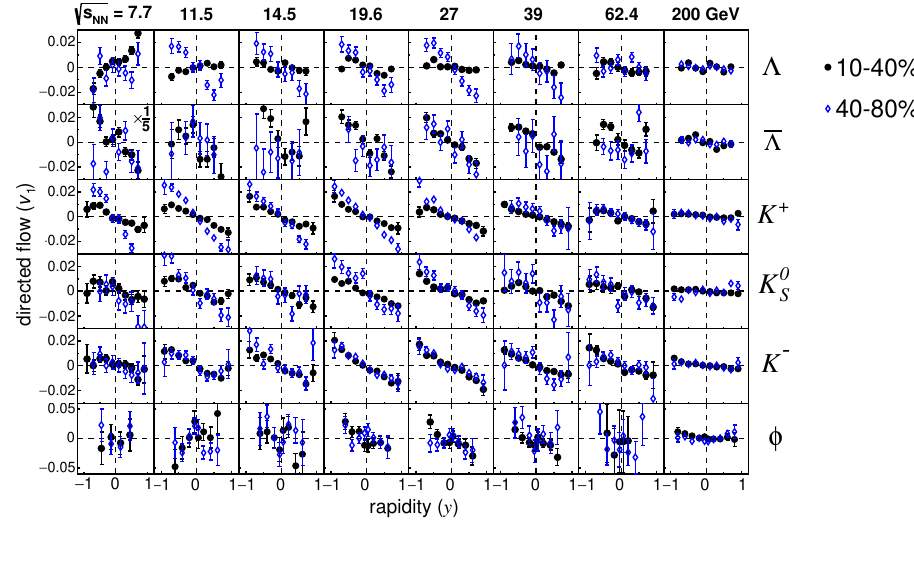
Figure 1. Directed flow as a function of rapidity for the six indicated particle species in 10-40% √ s NN = 7.7 to 200 GeV. The error bars include (black) and 40-80% (blue) central Au + Au collisions at statistical uncertainties only. All panels for species other than φ use the same v 1 scale with the exception √ s NN = 7.7 GeV, where v 1 magnitudes are exceptionally large and require the measurements to of ¯ Λ at be divided by